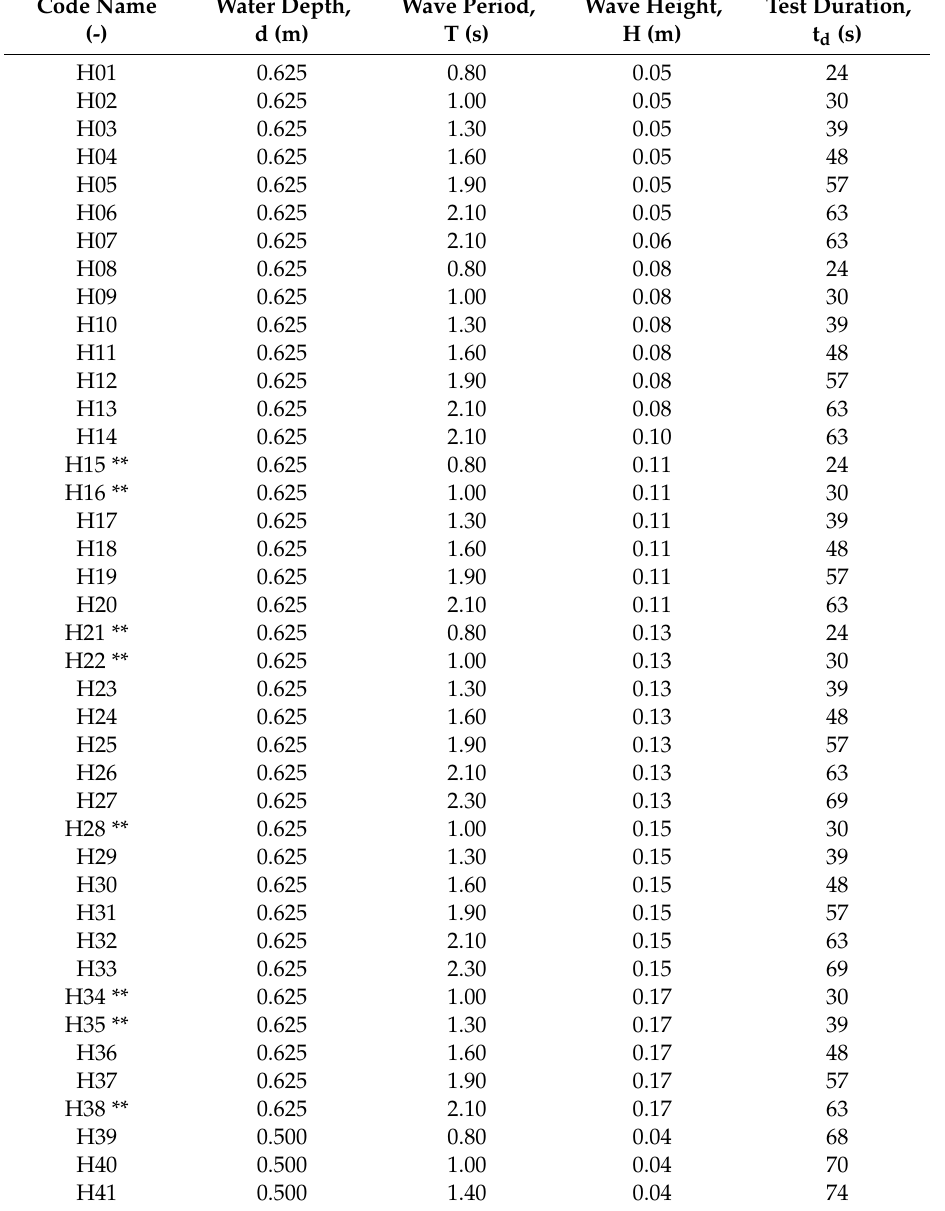
Table 3. Tests matrix showing hydrodynamic conditions for regular waves, test duration, and the naming of the performed